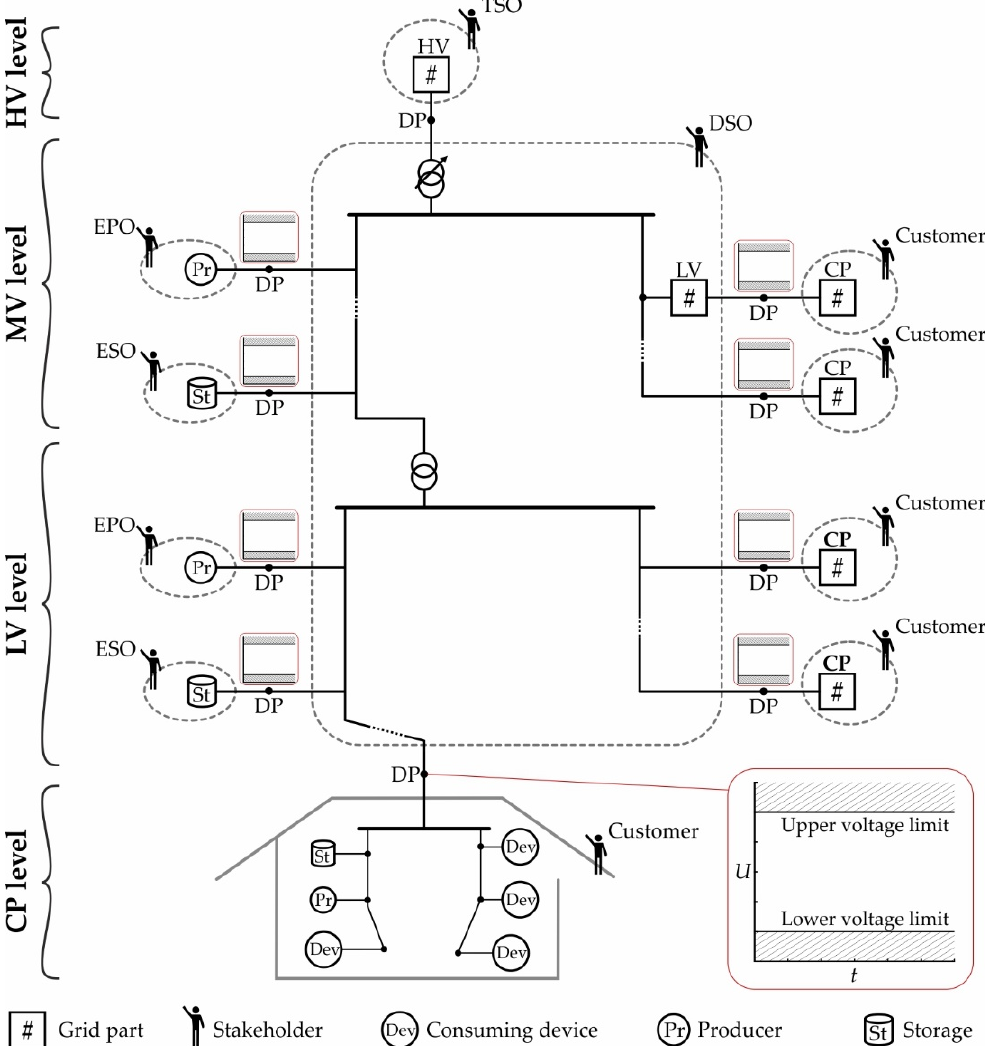
Figure 1. Overview of the voltage limits on the vertical axis of smart grids as specified by European Grid Codes.